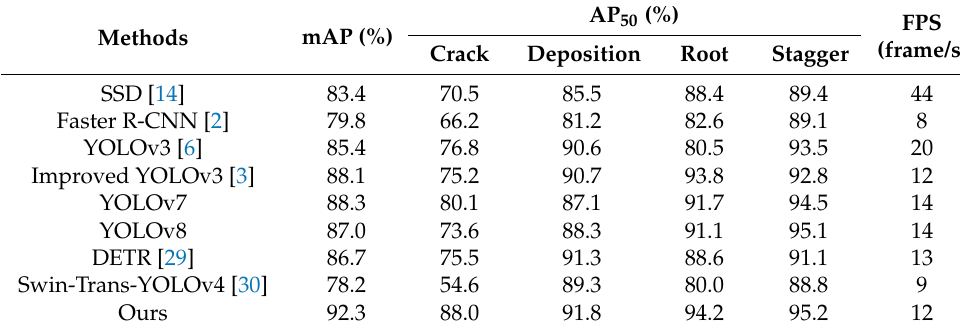
Table 6. Performance comparison of the different models.